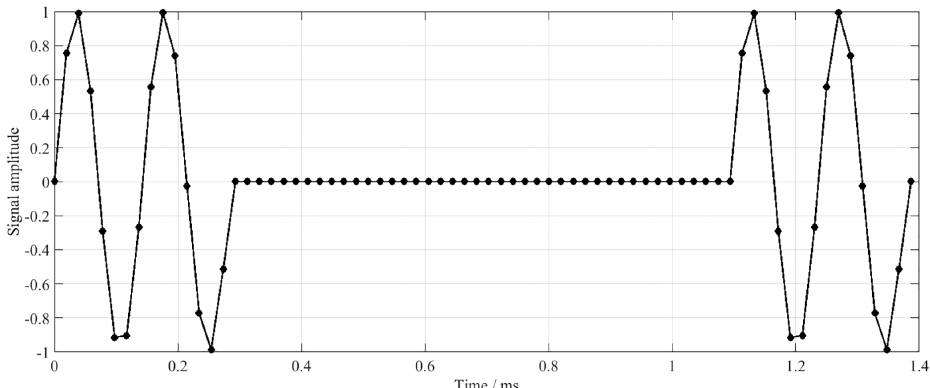
Figure 4. Theoretical acoustic signal consisting of 2 × 2 sine periods with a frequency of 7kHz interrupted by a break. The sample rate of the analogue-to-digital converter is